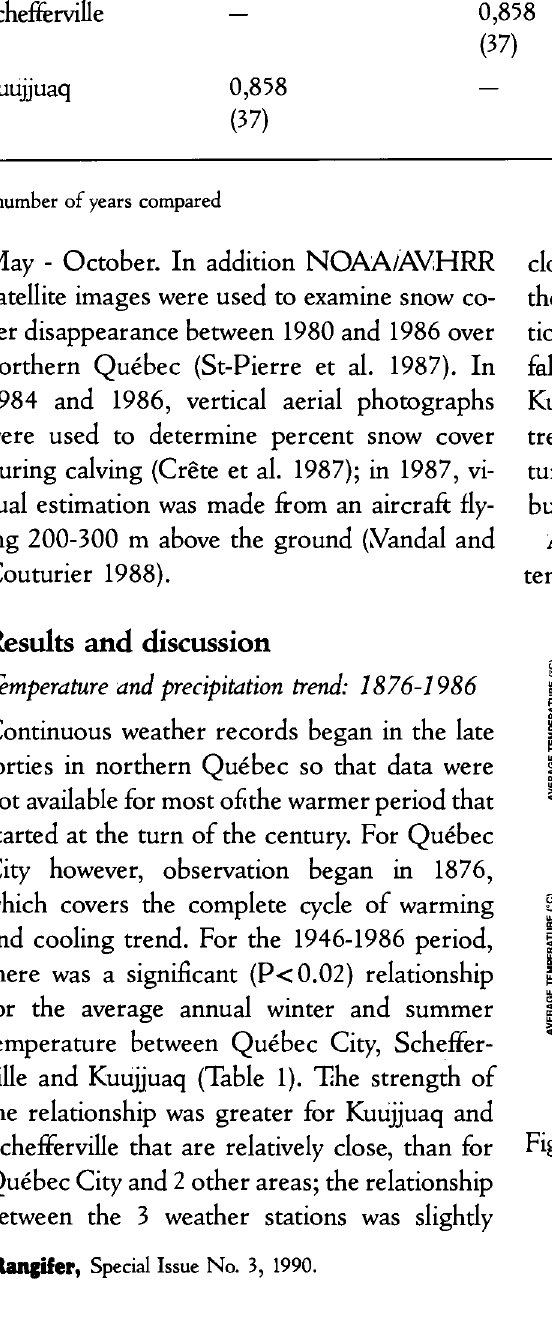
Fig. 2. Average winter (November-April) and summer (May-October) temperature be tween 1876 and 1986 in Québec